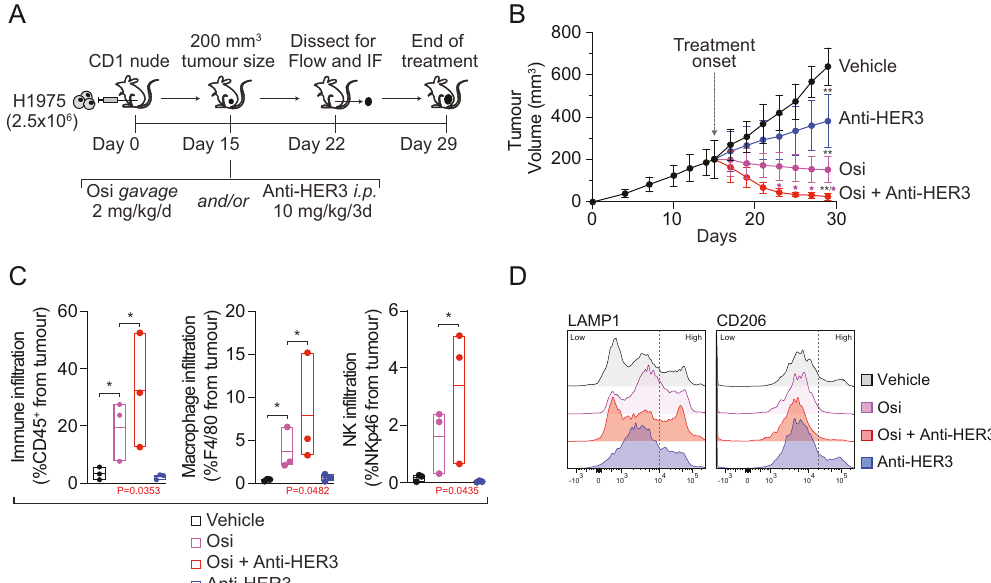
Fig. 4 Combination therapy with osimertinib and anti-HER3 antibodies shows increased ef fi cacy and immune engagement in vivo. A Diagram illustrating in vivo xenograft experimental design; 2.5 × 10 6 H1975 cells were injected s.c . into CD1-nude mice. Once tumor volumes reached 200 mm 3 (day 15), mice were divided into 4 groups and treatments begun as indicated, with daily osimertinib (Osi) or vehicle (hydroxyl propyl methyl cellulose) oral gavage and/or i.p . injections every 3 days (PBS or Anti-HER3, MP-RM-1). After 7 days (day 22), 6 mice per group were collected for tumor analysis, n = 3 for fl ow cytometry and n = 3 for immuno fl uorescence (IF) microscopy studies; the n = 6 remaining mice per group were kept for tumor size monitoring until day 29. B . Tumor volumes are shown for each group as indicated, mean ± SD. Statistical signi fi cance with one-way ANOVA with Tukey ’ s multiple group comparison test revealed * P < 0.05 and ** P < 0.01, indicated above each tumor group, black asterisks are relative to vehicle group and magenta asterisks are relative to Osi group at the timepoints indicated. C Quanti fi cation of immune in fi ltration (CD45 + , F4/80 + and NKp46 + ) using fl ow cytometry from tumors dissected from treatment groups de fi ned in panel A . Data shown as fl oating boxes (mean ± interval) including datapoints. * P < 0.05 as indicated, using one- way ANOVA with Tukey ’ s multiple group comparison test with individual P values shown in red comparing Osi vs . Osi + Anti-HER3 groups. D Overlay histogram plots comparing marker expression (LAMP1 and CD206 low and high populations) in tumor in fi ltrating macrophages. Graphs are representative from individual treatment groups as detailed in panel A (Fig. 4C), but not a signi fi cant increase in in fi ltrating CD45 + CD11b + cells (Fig. S5A), consistent with a degranulation pheno-